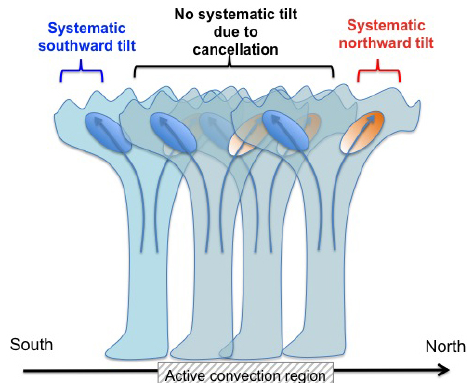
Figure 9. Schematic diagram showing the explanation of systematic poleward UT cloud tilts at the north and south peripheries of active tropical convection